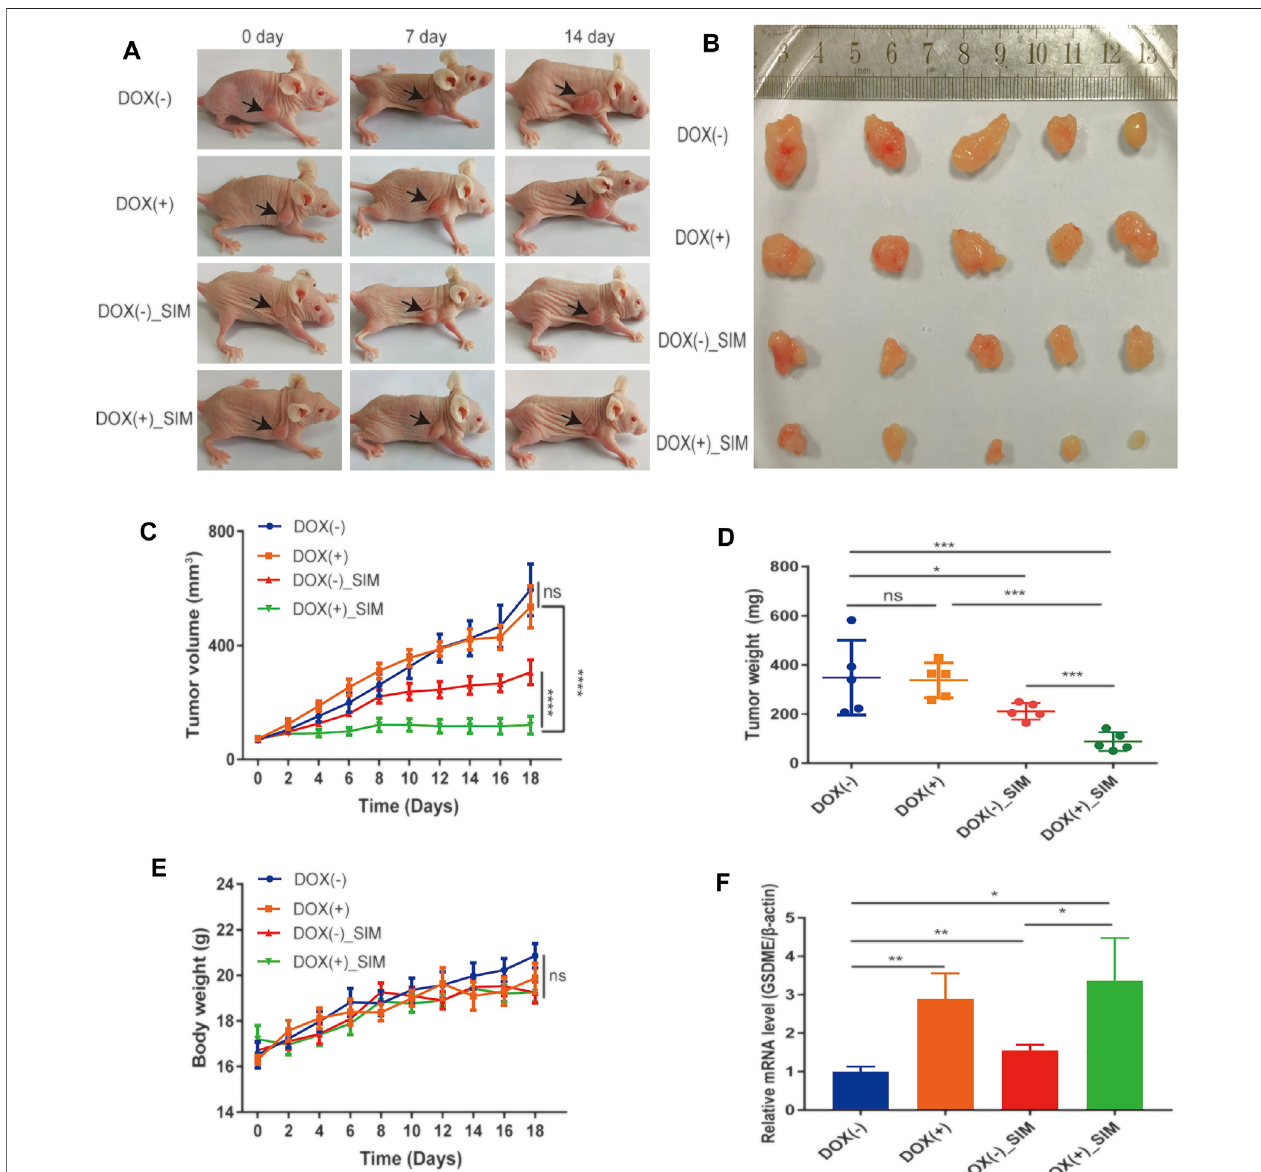
FIGURE4| SIMandGSDMEoverexpressionadditivelyinhibittumourgrowthinmousexenografts. (A) Photosofmicewithxenografttumoursduringthetreatment. (B) Tumoursdissectedandimagedattheendpointofexperiment. (C) Tumourvolumesduringthetreatment( n =5). (D) Tumourweightsattheendoftheexperiment( n = 5). (E) Average body weight of each group ( n = 5) (F) The of GSDME gene expression in xenograft tumour tissues, detected by RT-qPCR ( n = 3). p p < 0.05, pp p < 0.01, ppp p < 0.001, pppp p < 0.0001 and p > 0.05 not signi fi cant (ns).